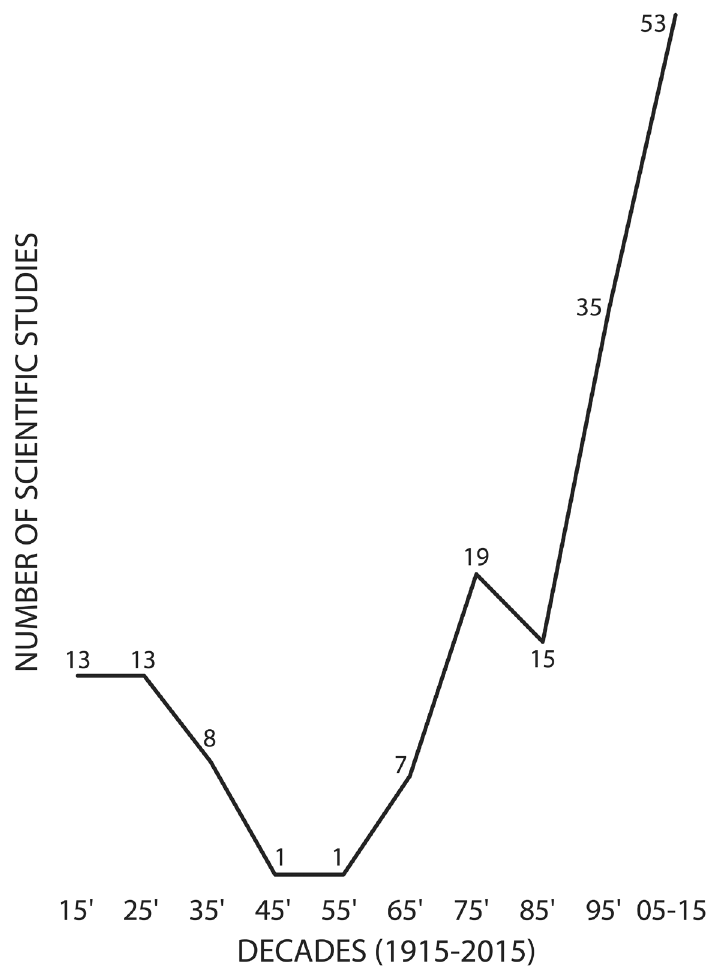
Figure 2. Number of studies regarding the Falconidae family published in the last century (from 1915 to